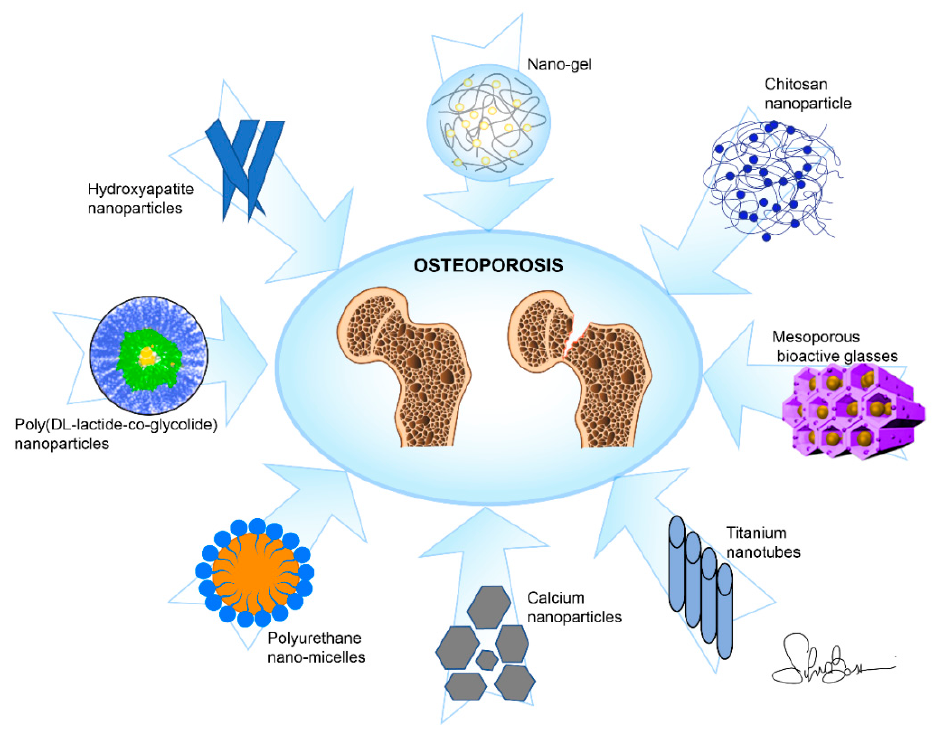
Figure 3. Main nano-based materials used as drug delivery systems against osteoporosis in this review.